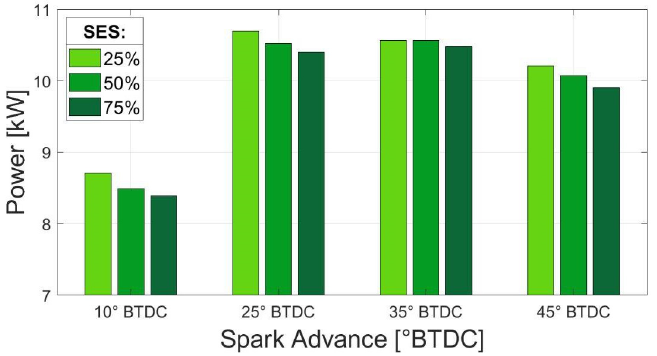
Figure 6. Output power for different spark advance and syngas energy share.